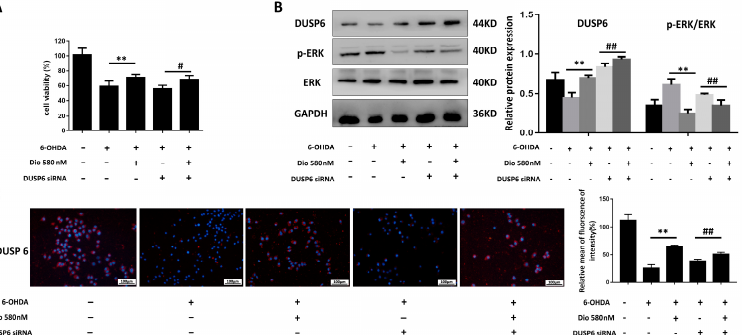
Figure 8. DUSP6 siRNA affected the effect of dioscin on the DUSP6 level in 6-OHDA-induced cells. ( A ) Effects of dioscin on cell viability after DUSP6 siRNA transfection ( n = 6). ( B ) Expression levels of DUSP6, p-ERK/ERK in PC12 cells treated with dioscin after the transfection of DUSP6 siRNA ( n = 3). ( C ) Expression level of DUSP6 in PC12 cells treated with dioscin after the transfection of DUSP6 siRNA by immunofluorescence assay ( n = 3). Data are expressed as the mean ± SD.** p < 0.01 compared with the 6-OHDA group; # p < 0.05 and ## p < 0.01 compared with the 6-OHDA + DUSP6 siRNA group.